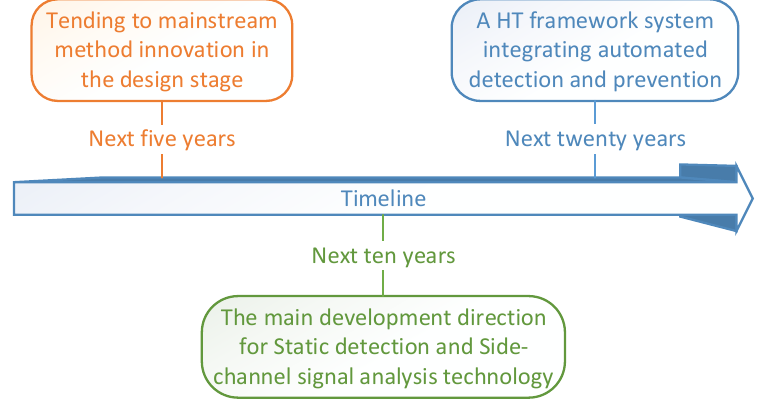
Figure 13. The future trend of